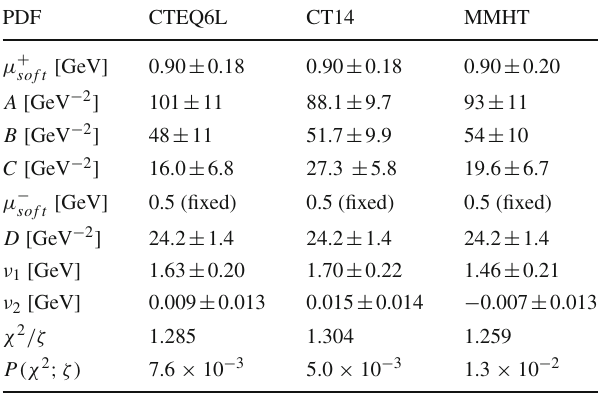
Fig. 3 Global 1 σ -fit of total cross section, σ pp eter. Best fit parameters and quality estimators are given in Table